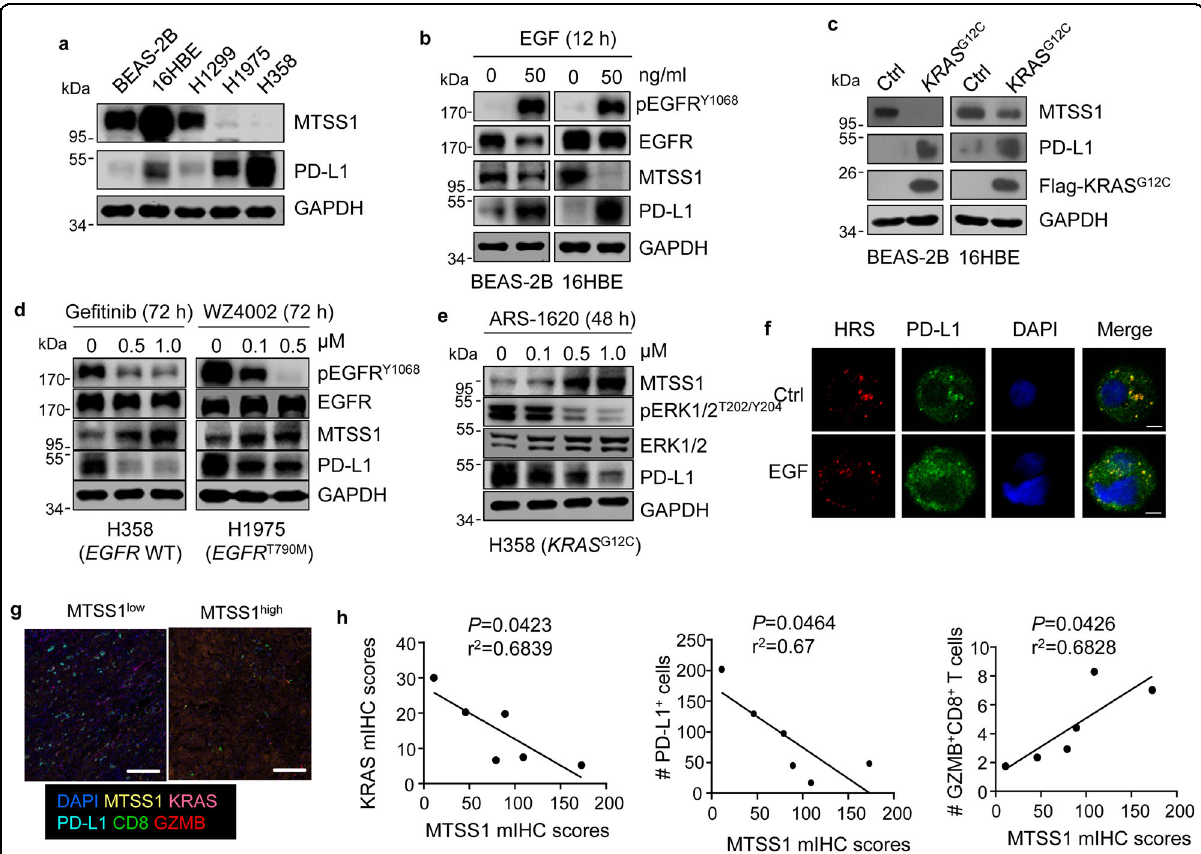
Fig. 5 EGFR – KRAS signaling suppresses MTSS1 expression and PD-L1 monoubiquitination. a MTSS1 and PD-L1 expression in indicated normal bronchial epithelial cells (16HBE and BEAS-2B) and lung cancer cells (H1299, H1975 harboring EGFR T790M and H358 harboring KRAS G12C ). b , c Immunoblots of BEAS-2B and 16HBE cells treated with EGF for 12 h ( b ), or after KRAS G12C overexpression ( c ). d Immunoblots of H358 treated with Ge fi tinib for 72 h or H1975 cells treated with WZ4002 for 72 h. e Immunoblots of H358 treated with various doses of ARS-1620 for 48 h. f IF analyses for colocalization of PD-L1 with HRS in 16HBE with or without 50 ng/mL EGF treatment for 15 min. Scale bars, 5 μ m. g , h Representative mIHC staining images ( g ) and correlation of MTSS1 staining scores with KRAS scores, PD-L1 + cells, and GZMB + CD8 + T cells ( h ) in human LUAD samples ( n = 6). Scale bars, 100 μ m. P values were calculated by Pearson correlation analysis ( h